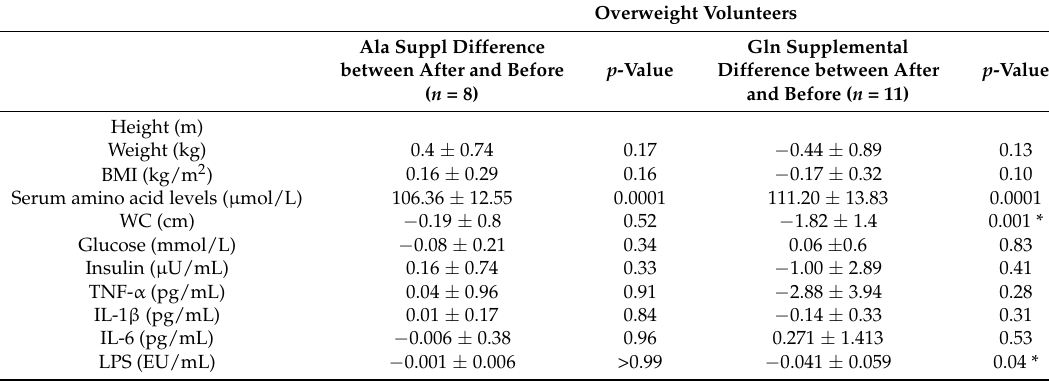
Differences in metabolic characteristics of overweight volunteers before and after supplementation with glutamine or alanine. Overweight